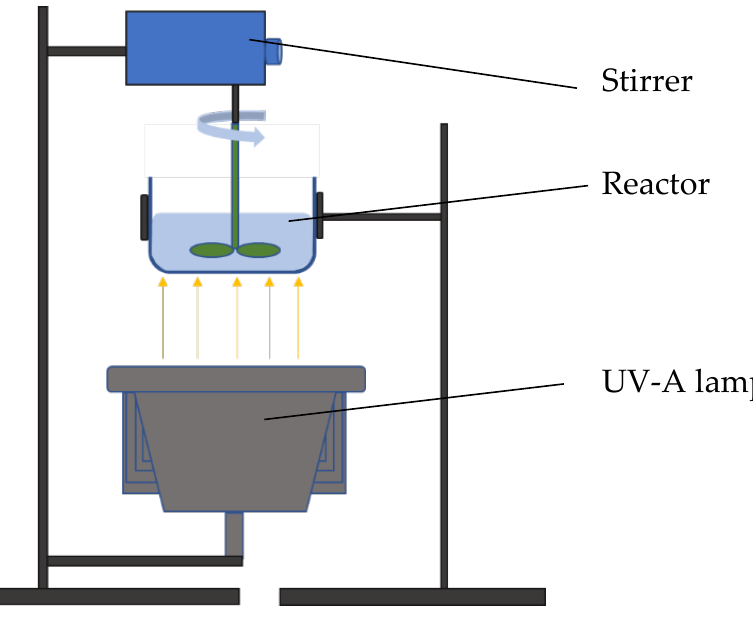
Figure 11. The reactor for photocatalytic measurements.